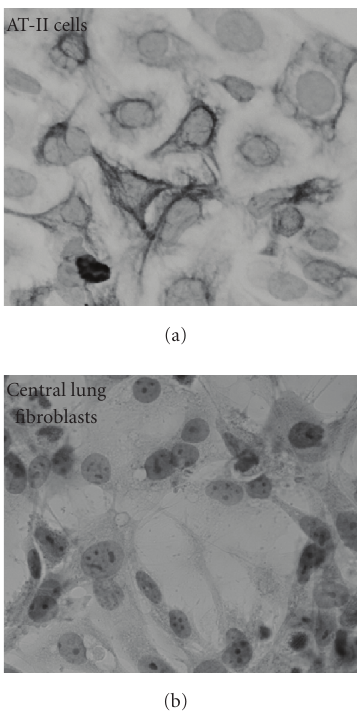
Figure 1: Alevolar cells type II (AT-II) and central lung fibroblasts stained with cytokeratin antibody. Note that AT-II stain positive for cytokeratin whereas fibroblasts do not. Therefore, contamination of AT-II cells in fibroblast cell cultures can be